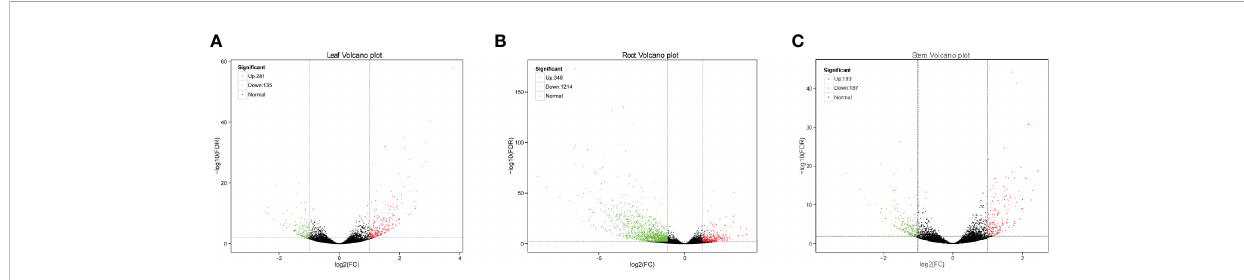
FIGURE 2 Volcano plot showing the numbers of DEGs among the three K.obovata seedlings organizations. The x-axis represents the fold-change (FC) of gene expression among samples. The more different genes are at either end. The y-axis represents the signi fi cance of the shift in gene expression, which is indicated by -log10. The y is the P-value (t-test) negative log, as adjusted by the false discovery rate (FDR). Genes that were signi fi cantly differentially expressed are represented by red dots (up-regulated) and green dots (down-regulated), while insigni fi cantly differentially expressed genes are represented by black dots. Leaf: 281 up-regulated genes and 135 down-regulated genes. Root: 346 up-regulated genes and 1214 down- regulated genes. Stem: 183 up-regulated genes and 187 down-regulated